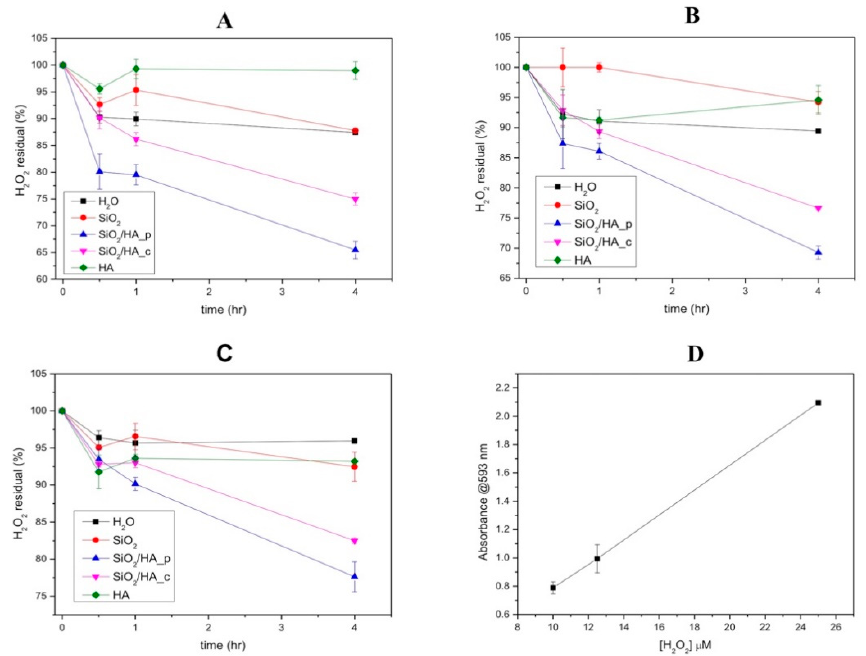
Figure 10. Antioxidant properties of SiO 2 , SiO 2 /HA_p and SiO 2 /HA_c NPs and pure HA at different hydrogen peroxide concentrations: ( A ) 10 µ M, ( B ) 12.5 µ M and ( C ) 25 µ M; ( D ) standard calibration curve for hydrogen peroxide determination.